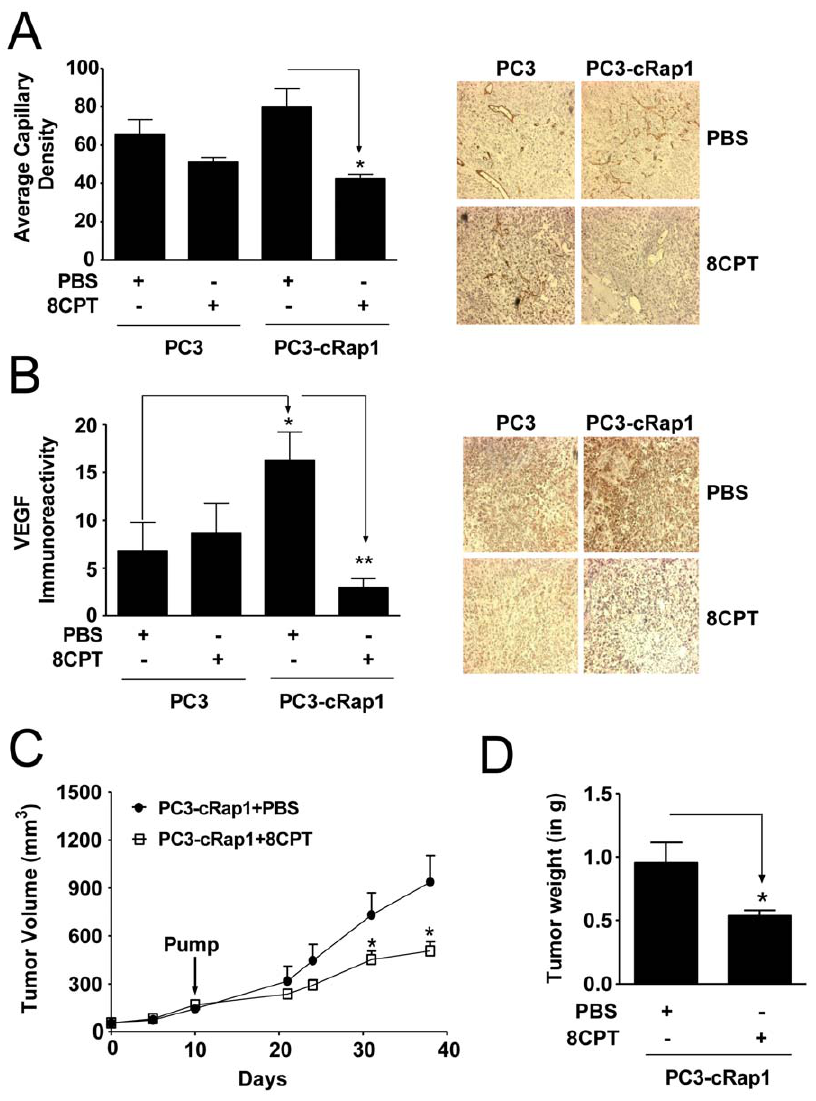
Figure 2. Effect of 8CPT treatment on angiogenesis and tumor growth in PC3 and PC3-cRap1 xenografts. (A and B) CD31 and VEGF immunoreactivity in PC3 and PC3-cRap1 tumors. Immunostaining was measured as described in Methods. Right Panels : Representative photomicrographs. Left Panels : Quantification of immunohistochemical staining of tumor slices; *p , 0.05; n=7; a.u.=arbitrary units. (C) Tumor volume (expressed in mm 3 ) of human PC3-cRap1 xenografts. PC3-cRap1 cells were injected as xenografts at Day 0 and allowed to grow for 10 days before a osmotic minipump containing the treatments was implanted for constant infusion (Day 10, pump). Tumors treated as indicated were measured as described in Methods; *p , 0.05; n=8 for each group. (D) Tumor weight of human PC3-cRap1 xenografts. Tumors from panel C were weighed at the end of the experiment (Day 38) and expressed in grams; *p , 0.05; ( n =8).